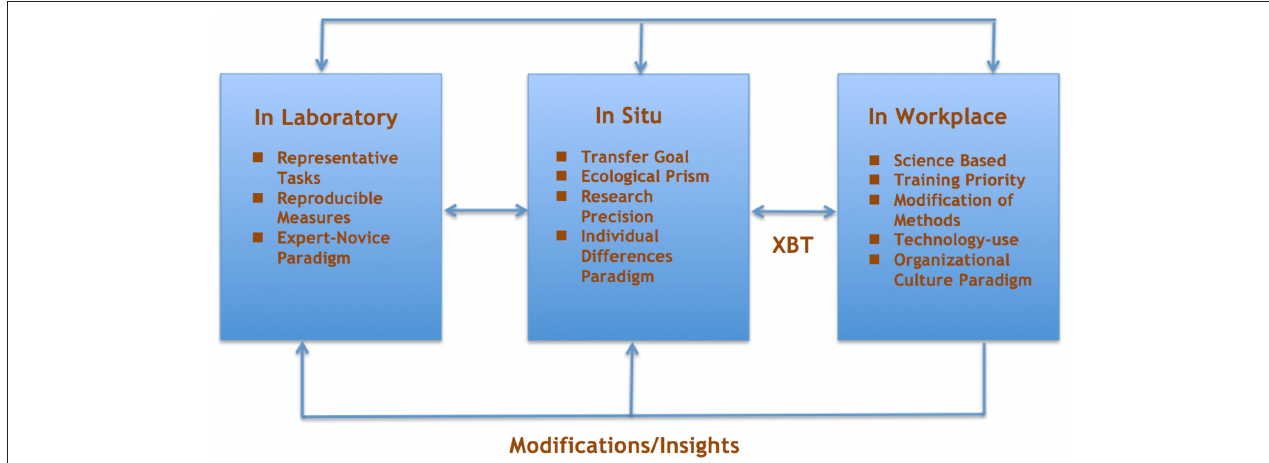
FIGURE 1 | Settings for expert performance